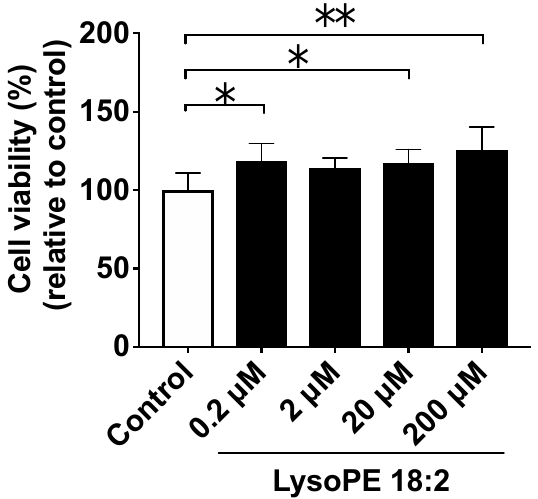
Figure 1. Cell viability assay of C3A liver-derived cells at 24 h after adding lysoPE 18:2. Cell viability in the control group was set as 100%. Results are expressed as mean ± standard deviation. n = 6. * p < 0.05, ** p < 0.01.